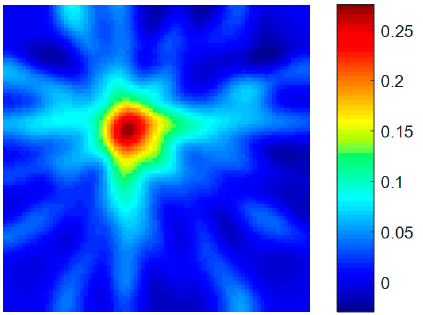
Figure 14. The tomographic imaging results with homogenization.